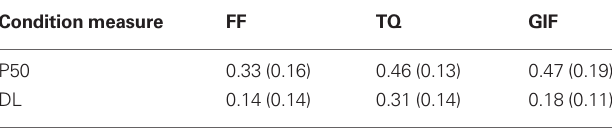
Table 1 | Median (iQr) of P50 and DL for all